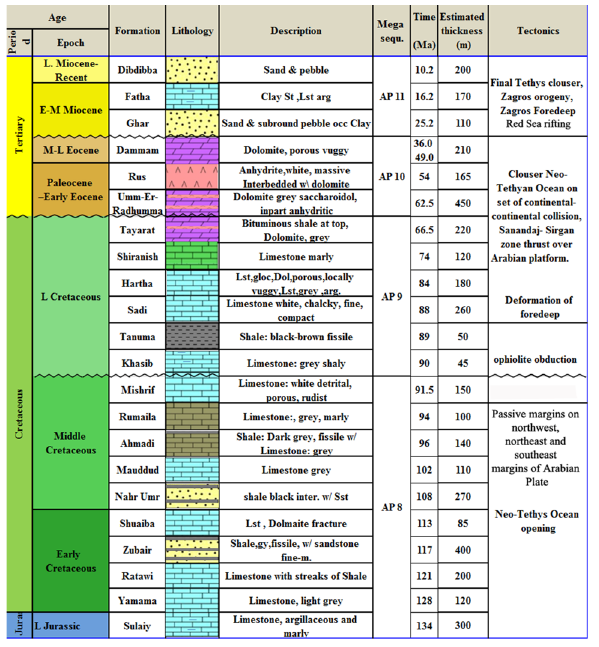
Fig. 2 Stratigraphic section of the Zubair oilfield (Jafar